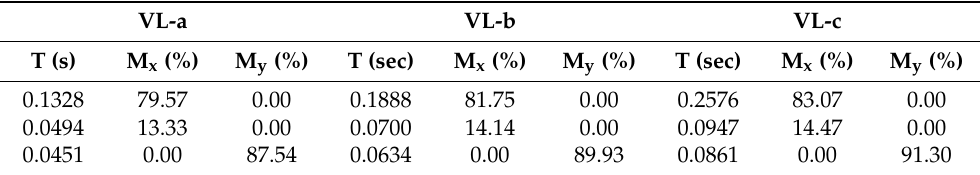
Table 3. Vibration modes and mass participation ratios for VL-a (at left), VL-b (at centre), and VL-c (at